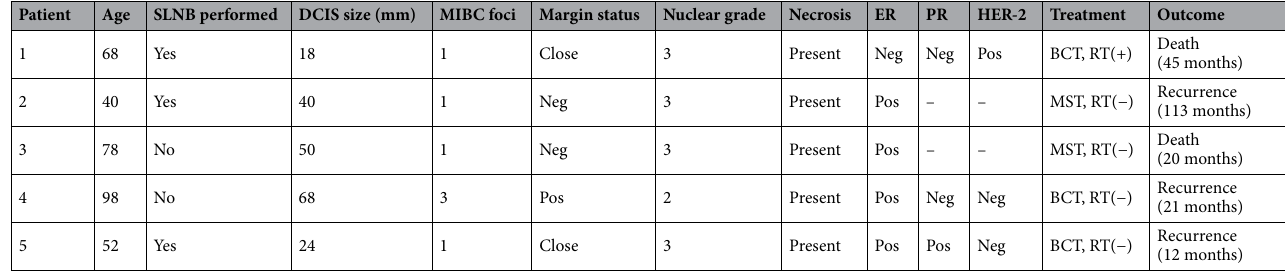
Table 2. Characteristics of patients with poor long-term outcomes. SLNB sentinel lymph node biopsy, DCIS ductal carcinoma in situ, MIBC microinvasive breast